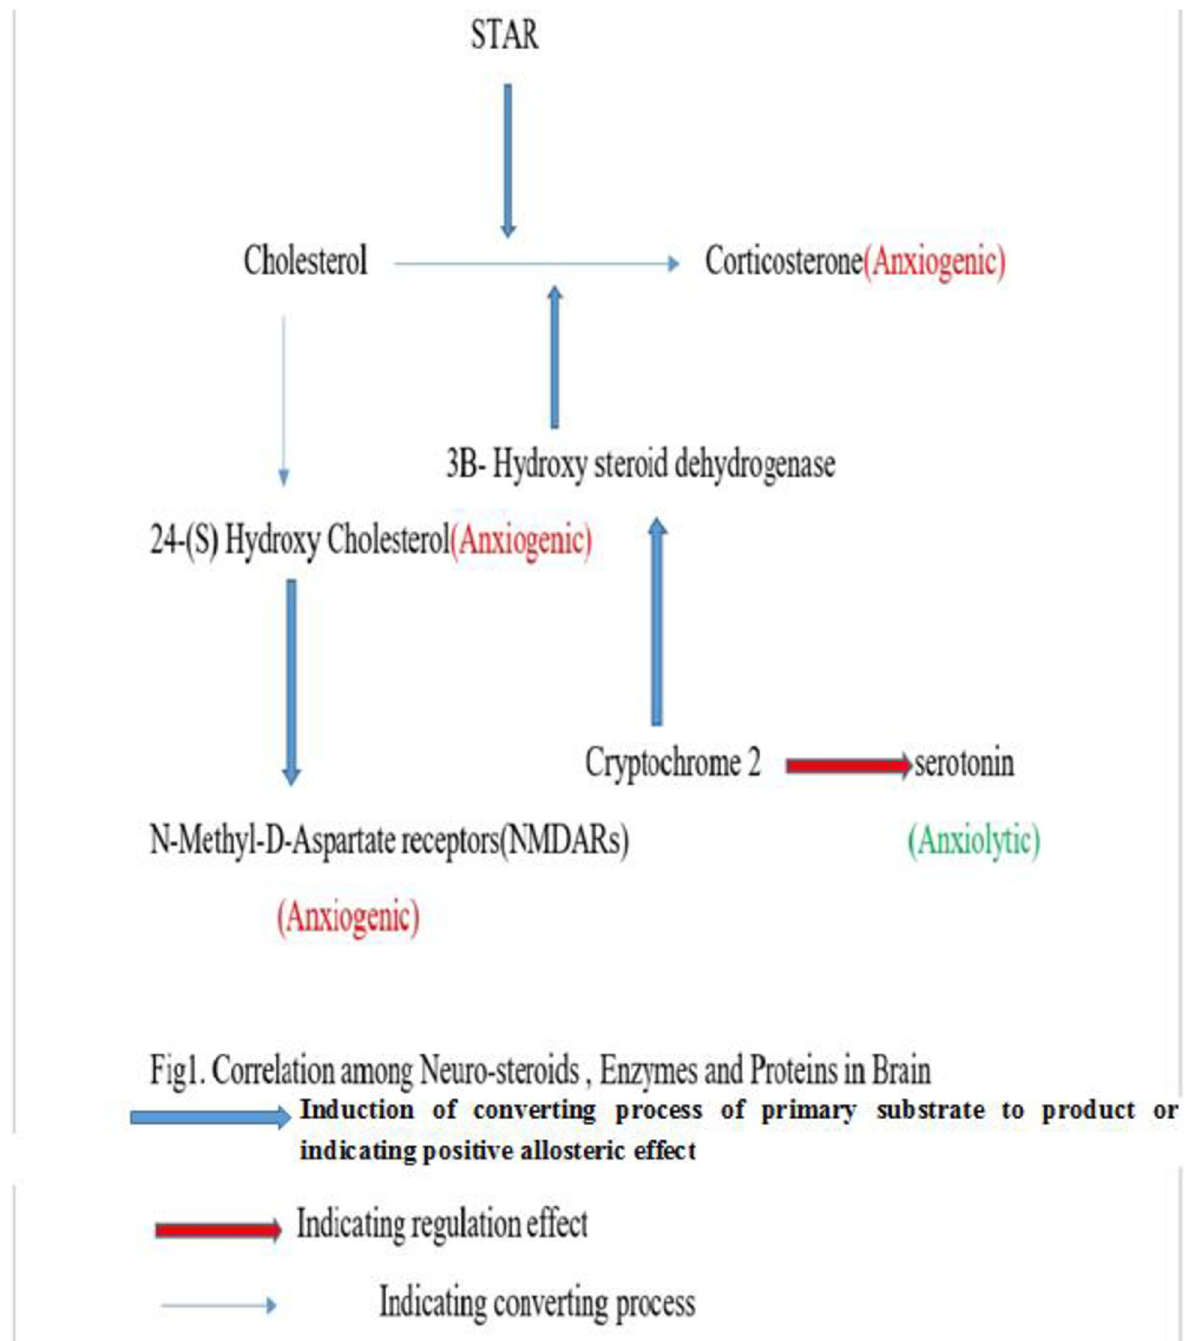
Fig 1. Correlation among neuro-steroids, enzymes and proteins in